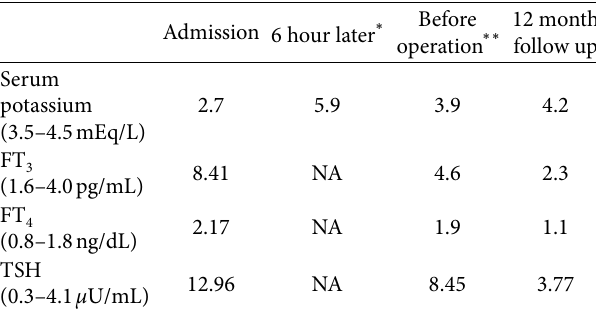
Table 2: Serum potassium levels and thyroid function tests at admission, during treatment, and follow-up